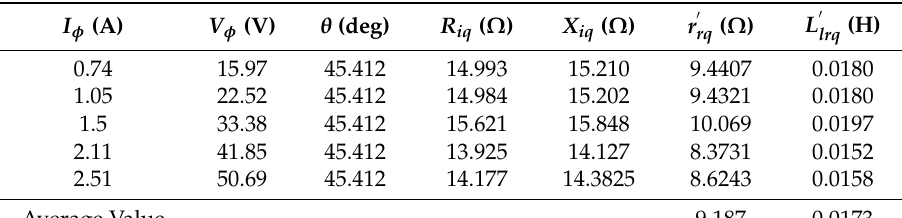
Table 5. The locked rotor test result (rotor q-axis aligned with